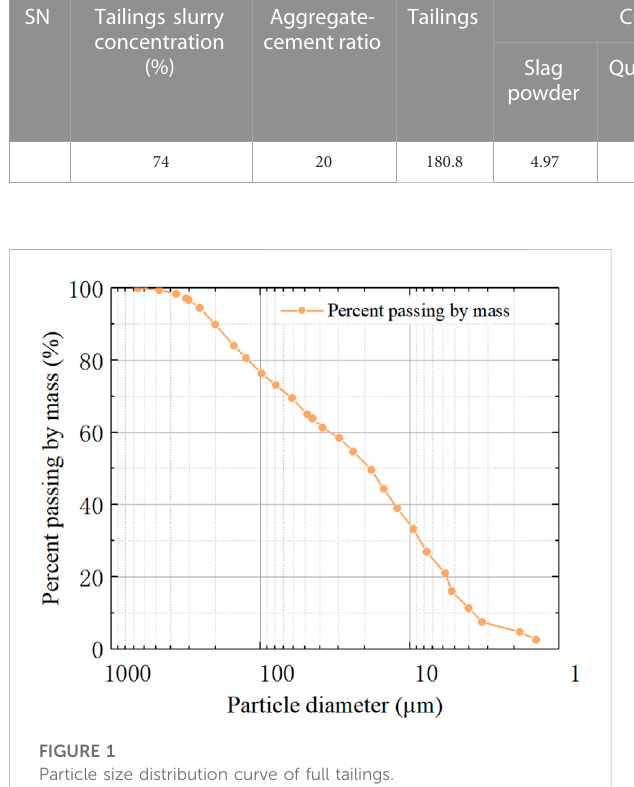
FIGURE 1 Particle size distribution curve of full tailings.